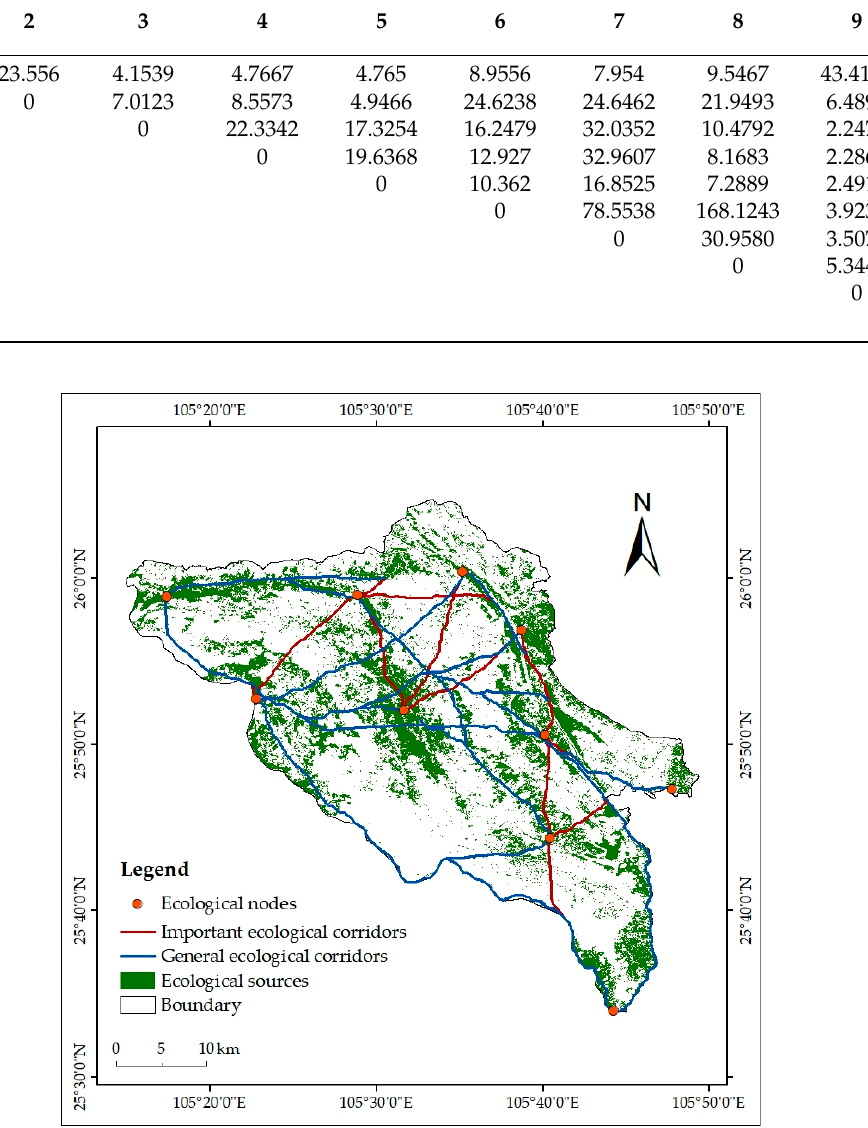
Figure 8. Landscape security pattern layout of Guanling County. Table 6. Interaction matrix between sources based on gravity model calculations.